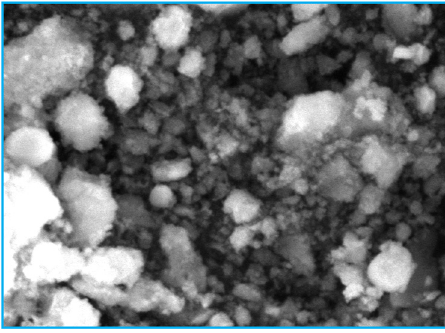
Figure 5: SEM analysis of C. baccifera synthesized ZnNPs.